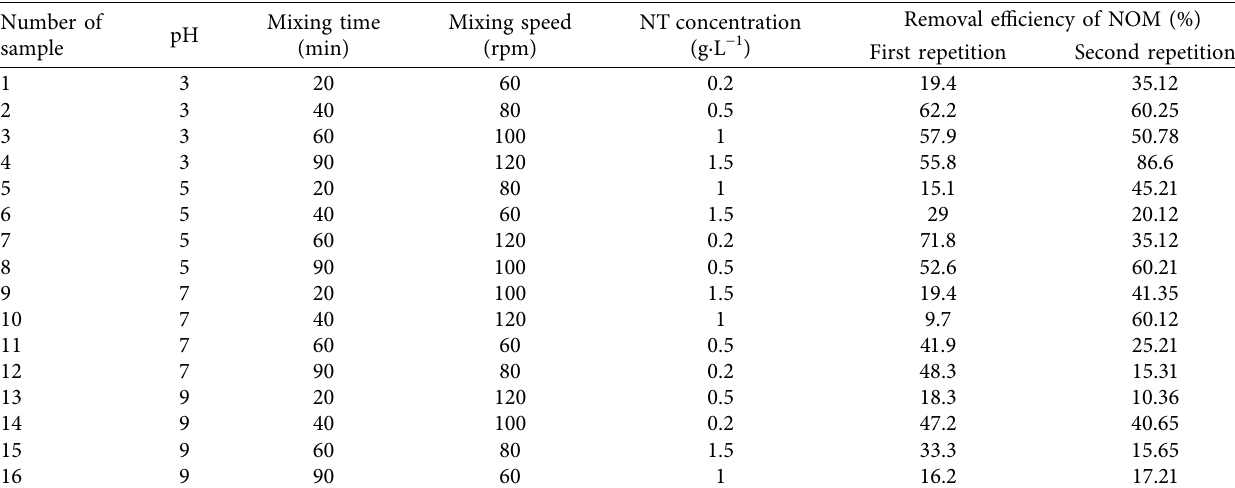
Table 4: Removal efciency of natural organic matter (HA) at a concentration of 10mg · L − 1